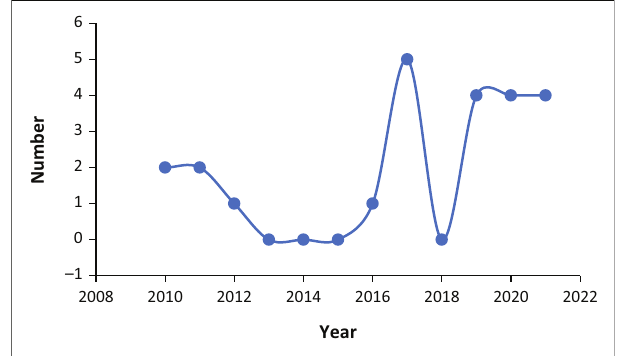
FIGURE 1: Relevant publication distribution over the years. FIGURE 2: Study disciplines of publication selected for literature